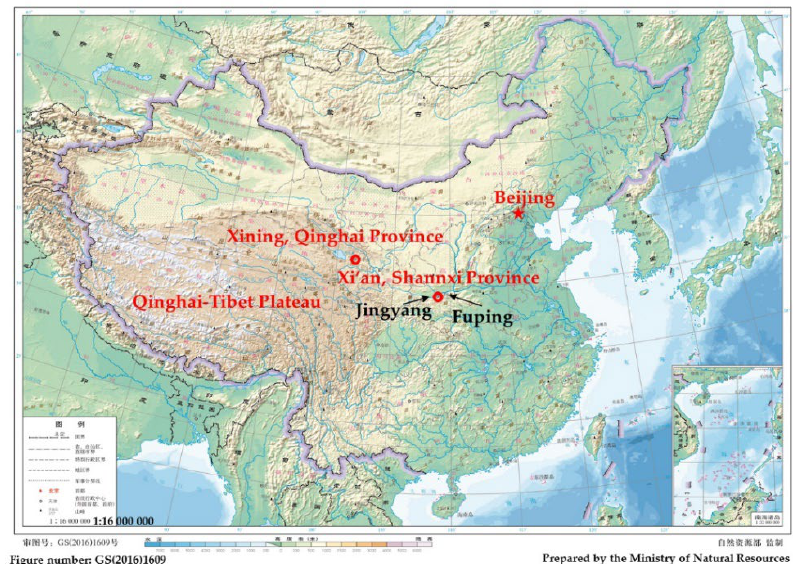
Figure 1. Topography map of China.